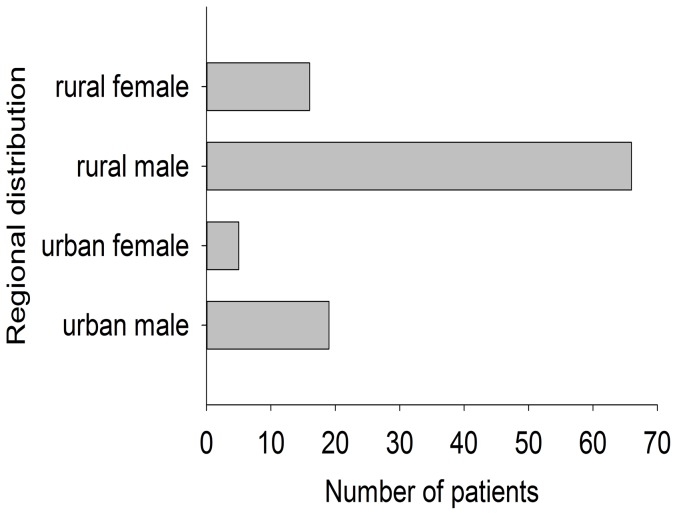
Regional distribution of total patients.